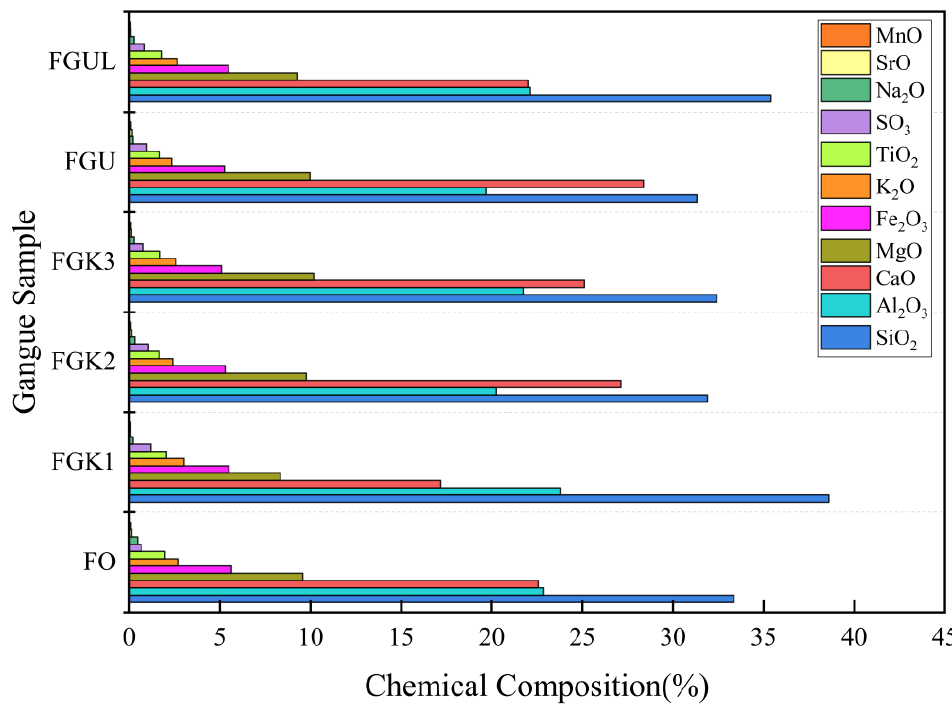
Figure 4. Column distribution diagram of the main components and their after-immersion residues in the raw gangue samples.